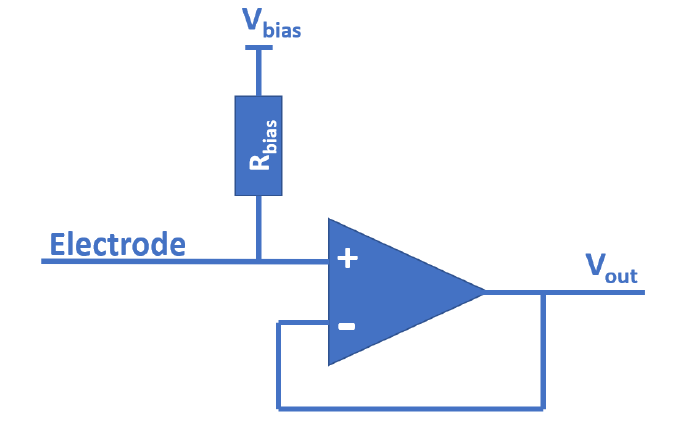
Figure 7. Simplified passive electric field